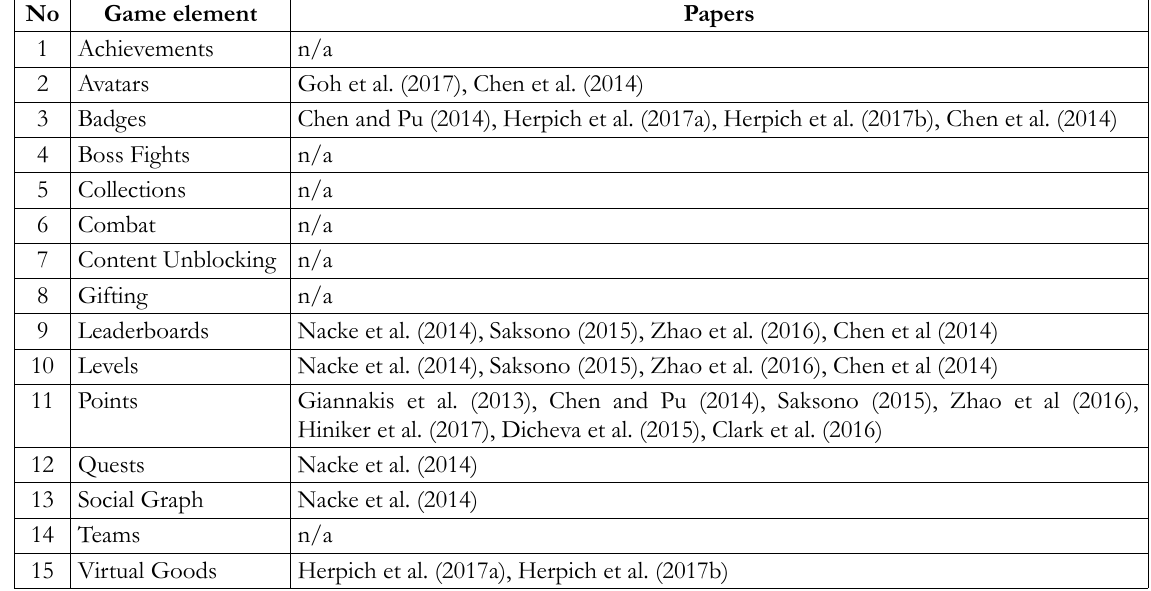
Table 3. Game elements: Components used in papers (Werbach & Hunter, 2012)